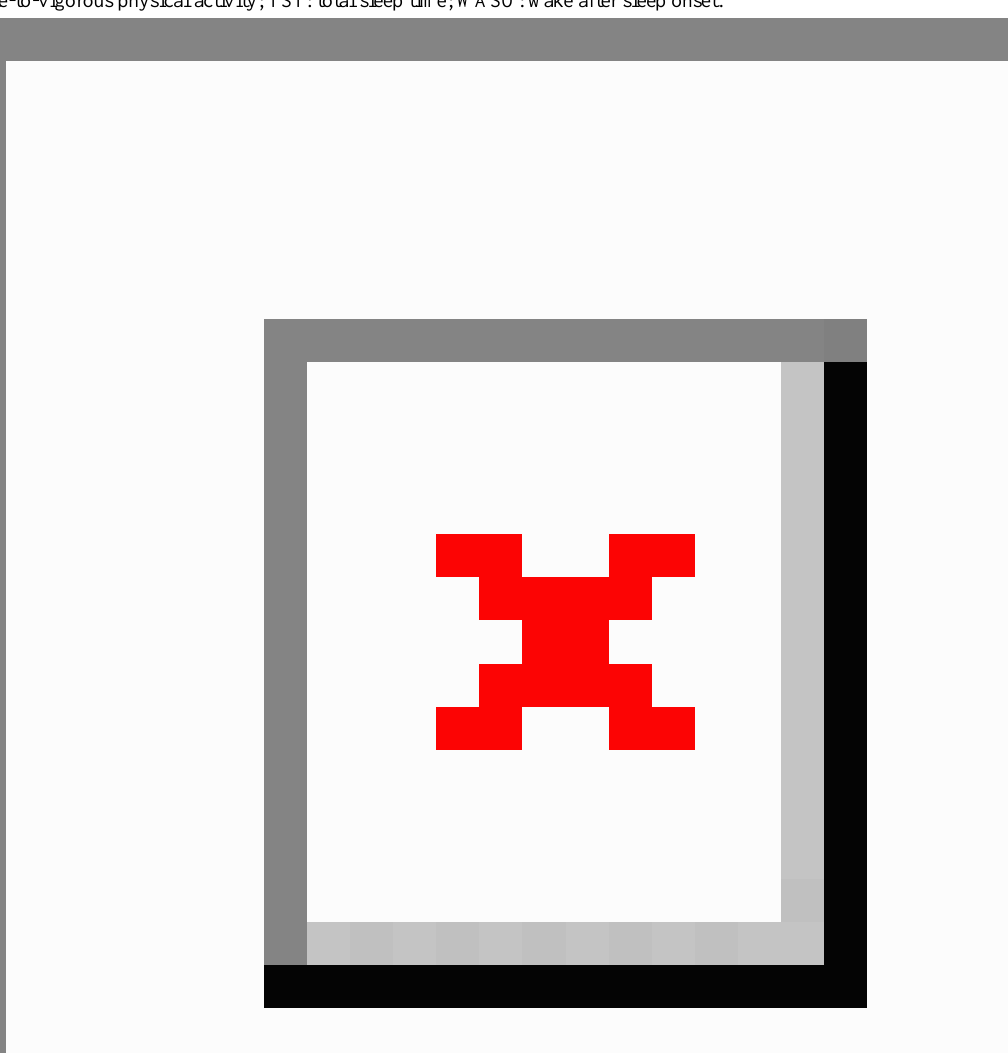
Figure 2. Mean absolute percentage error (MAPE) with standard deviation for each parameter and tracker. EE: energy expenditure; MVPA: moderate-to-vigorous physical activity; TST: total sleep time; WASO: wake after sleep